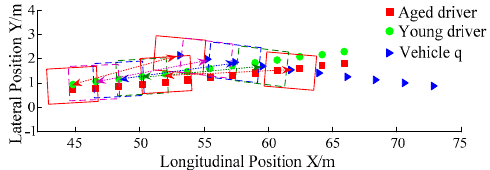
Figure 27. Trajectories of the vehicles driven by di ff erent drivers.